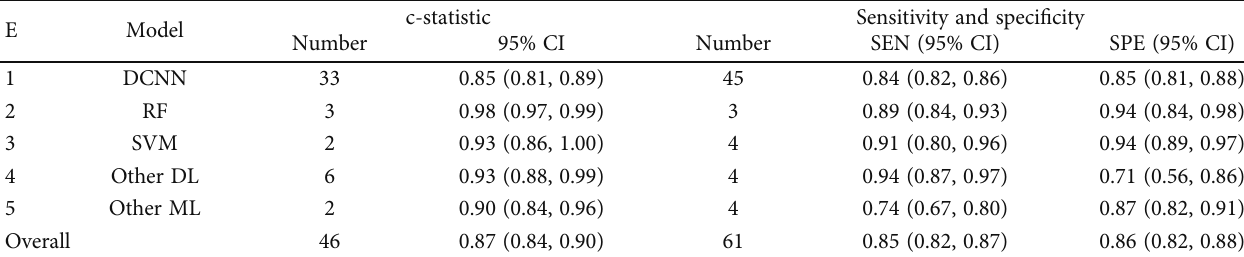
Figure 1: Flow chart for study selection process. Table 1: Summary of speci fi city and C -index in subgroup